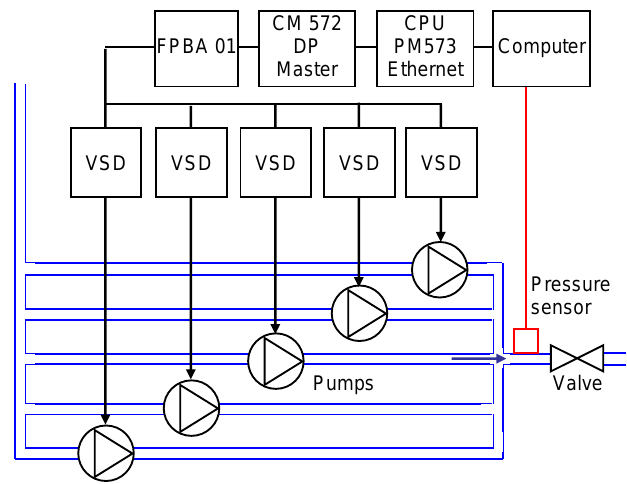
Fig. 5. Topology of the 5-pump